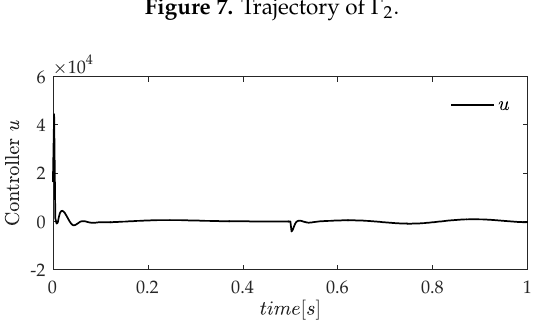
Figure 7. Trajectory of Γ 2 .